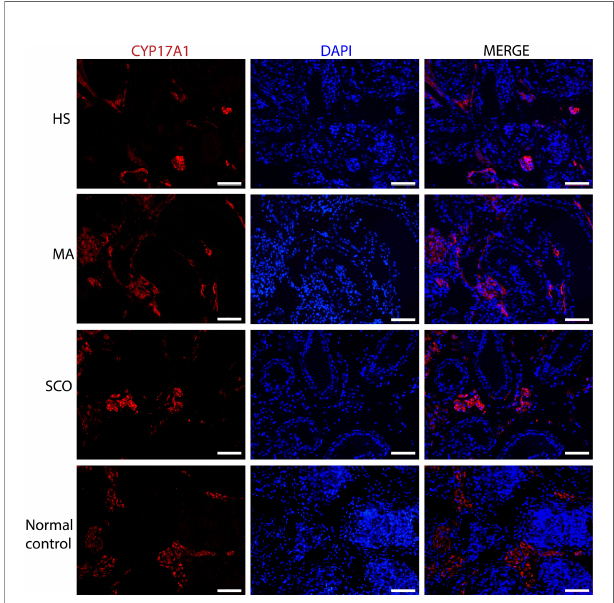
FIGURE 3 | Immuno fl uorescence staining of Leydig cell marker in un-dilated seminiferous tubules from HS, MA, SCO, and NC samples. CYP17A1 (red) for Leydig cells, DAPI (blue) for nuclear staining. Scale bar: 100 m